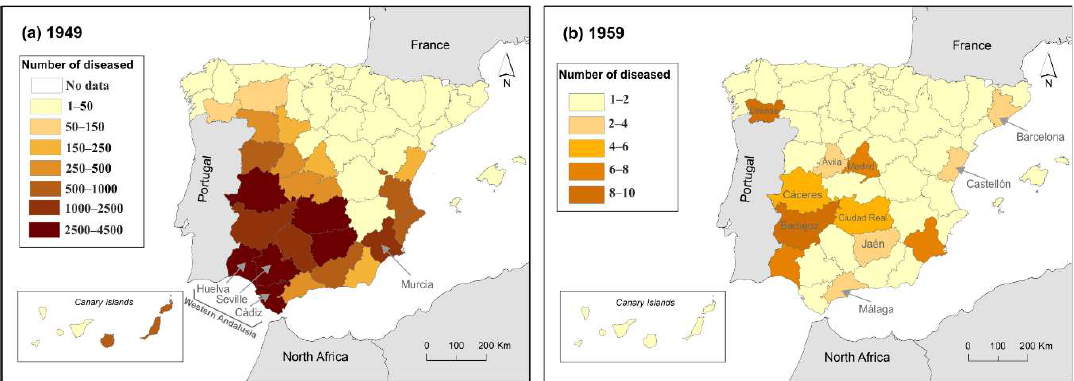
Figure 3. Spatial distribution of total number of people infected with autochthonous malaria in each Spanish province in: ( a ) 1949; and ( b ) 1959.